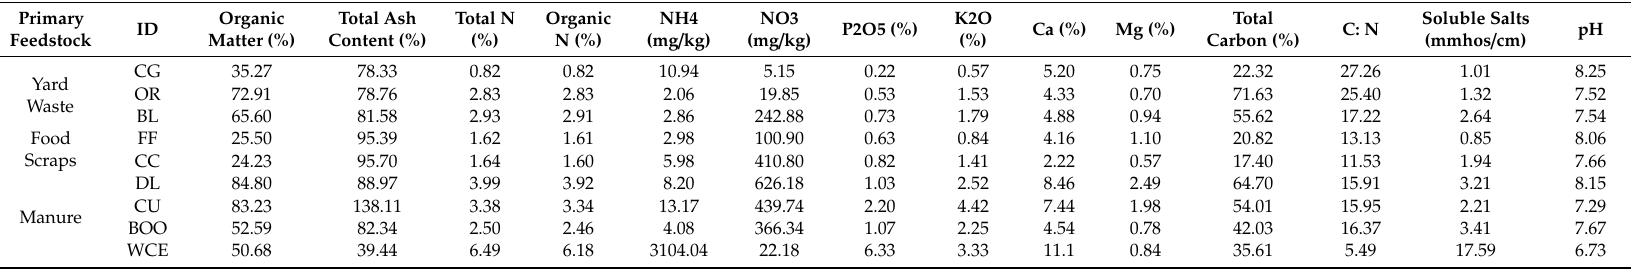
Table 2. This data table shows the mean of two samples of each of the 9 composts tested at the Cornell Nutrient Analysis lab. Most of the tests shown above were taken according to the TMECC protocol [7]. nitrate and ammonium content were found using a KCl